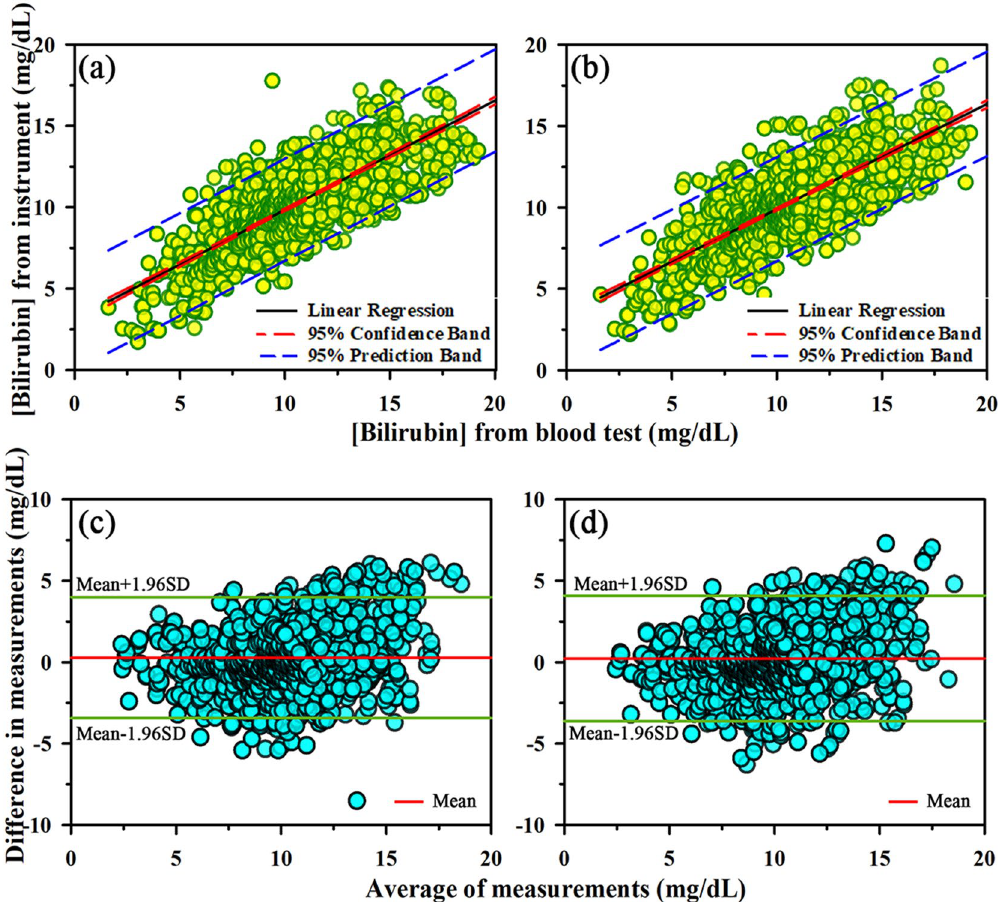
Figure 2. Relationship between paired bilirubin values obtained by AJO-Neo and conventional TSB. Linear regression plots of AJO-Neo versus TSB in the total population (N = 1968) when AJO-Neo data were taken from ( a ) right nail bed and ( b ) left nail bed. Bland–Altman plots (mean and limits of agreement) for the total population (N = 1968) when AJO-Neo data were taken from ( c ) right nail bed and ( d ) left nail